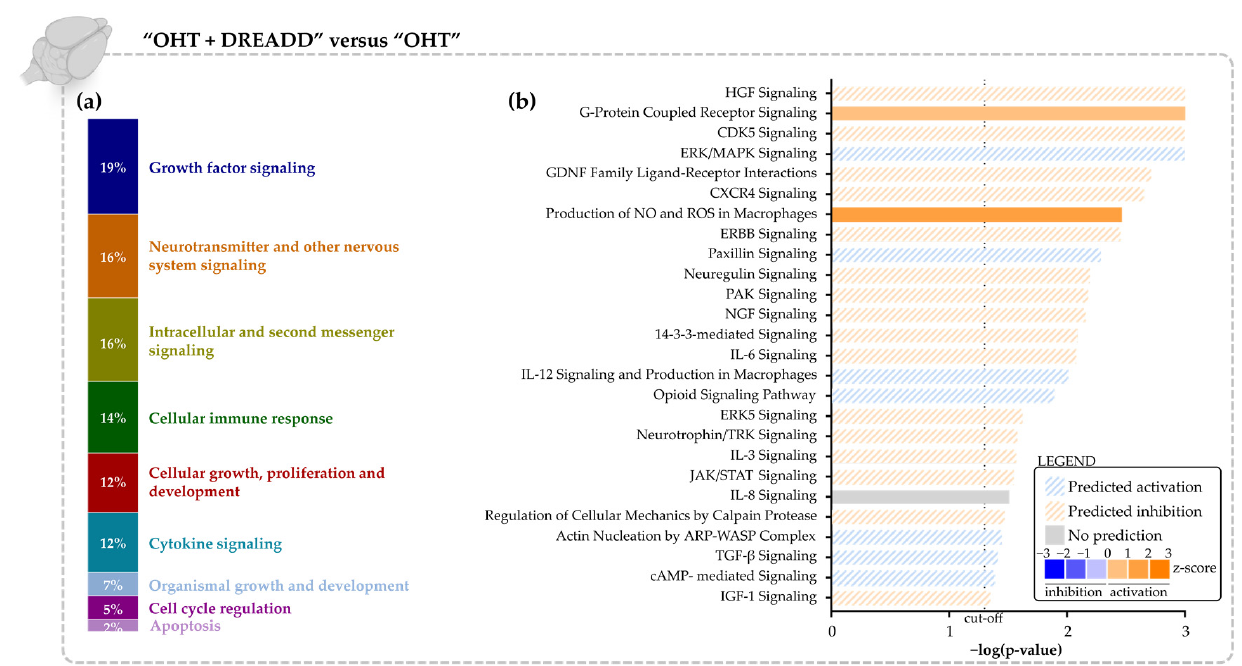
Figure 6. Canonical Pathway analysis in the “OHT + DREADD” vs. “OHT” dataset of the collicular transcriptome. ( a ) Overarching categories to which the altered canonical pathways belong. ( b ) List of altered signaling pathways, relevant to the biological question (FDR ≤ 0.1, − log ( p -value) ≥ 1.30, Fisher’s exact test). A list of all significantly altered canonical pathways is provided in Supplementary File S3. IPA predictions are algorithm- (based on z-score, filled bars) or user-defined (striped bars). Pathways that are predicted to be upregulated are shown in orange, those predicted downregulated in blue. A grey bar indicates that no prediction could be